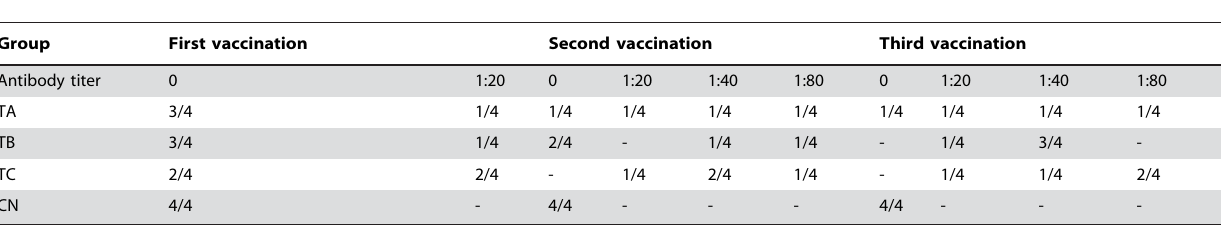
Table 1. The antibody titers of the rhesus monkeys were measured by ELISA.